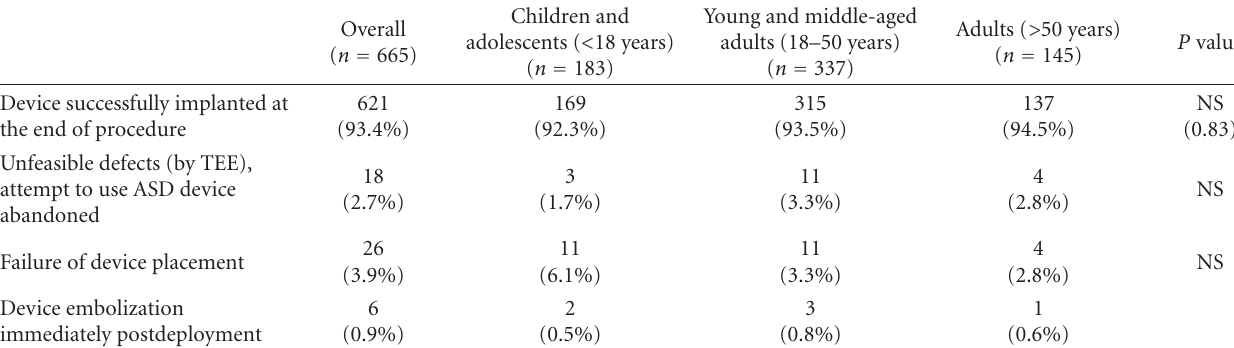
Table 2: Success and failure of transcatheter closure of ASD at the end of procedure ( n =